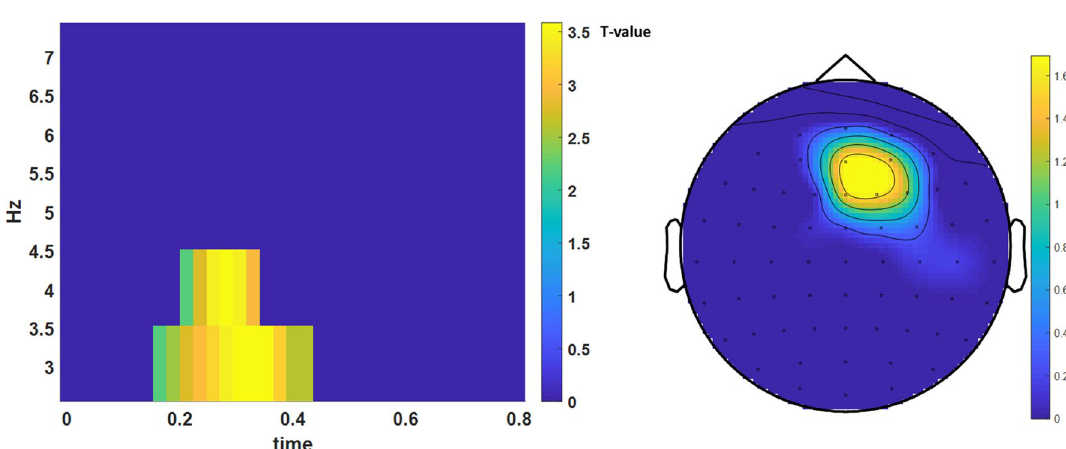
Figure 4. Pain evoked theta-band power measured before the first and the last training. Time-frequency resolved statistical (t-) values were shown at the maximum electrode AFz (left) and indicated different modulations of theta-band power across training between the two groups (only significant values after correction for multiple comparisons were shown). The interaction effect indicated an increase of pain evoked theta-band power in the group that trained to increase theta-band in the independent sessions around 300 ms after stimulus onset (0) and a decrease in the other group. In the right panel the topography of this effect is shown (n = 10 in every